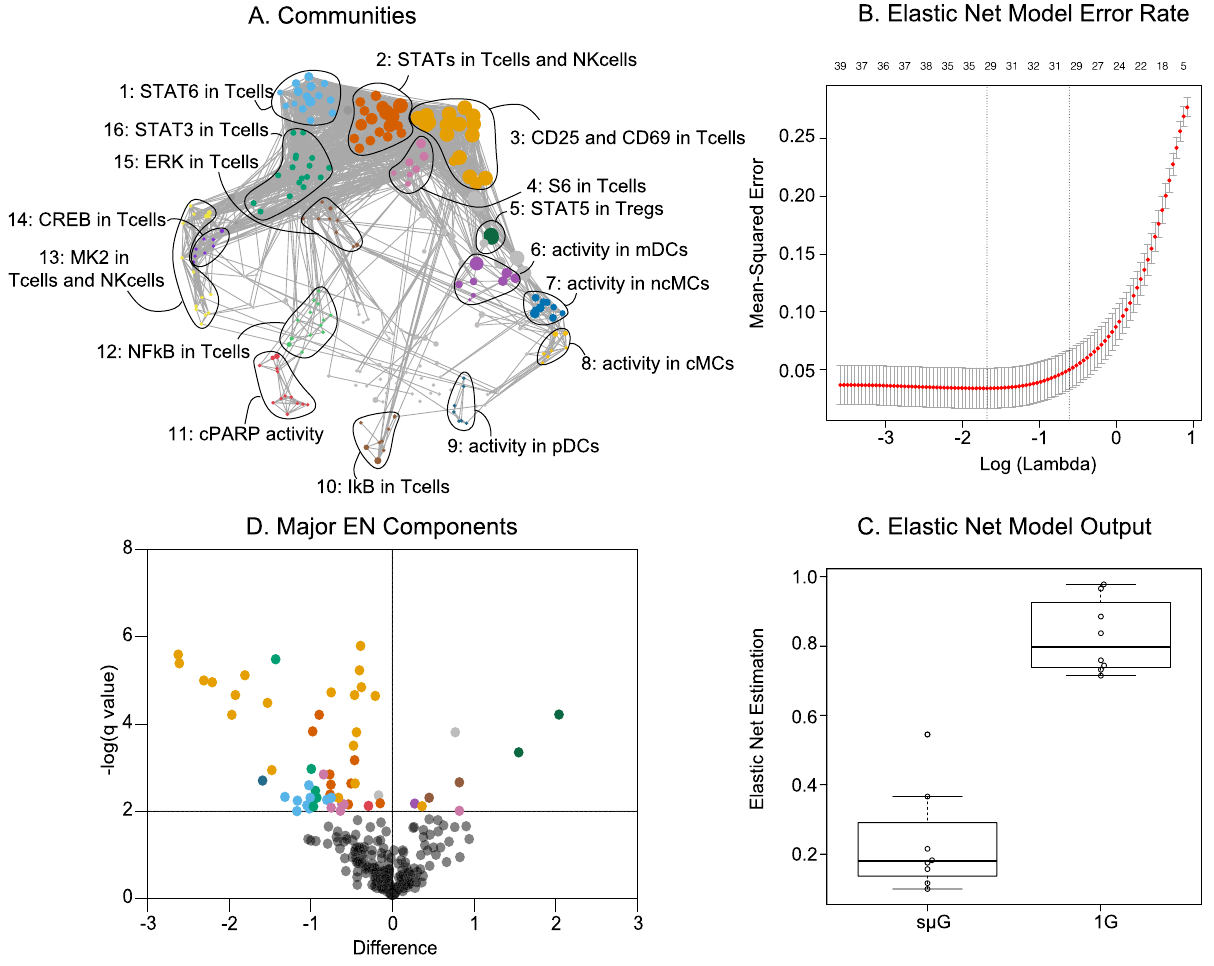
Figure 3. Multivariate modeling of immune cell adaptations to sµG analyzed using mass cytometry. ( A ) Correlation network depicting single-cell immune responses to ConA/anti-CD28 stimulation after sµG or 1G exposure. Nodes represent the protein expression or phosphorylation level of one of 14 functional proteomic markers for a given immune cell subset (asinh ratio relative to the unstimulated condition). Edges are proportional to the Spearman correlation between two nodes. The network segregates into 16 communities that were characterized based on the functional attribute that appeared most frequently in each community. ( B ) An EN method analysis of immune cell responses that differentiated samples exposed to sµG or 1G. The graph depicts model error rates after cross-validation across a range of regularization threshold [log(lambda)]. EN models with the lowest error rate (left vertical dotted line) and one standard deviation from the lowest error rate (right vertical line) are indicated. ( C ) EN model output ( p = 2E−4, Wilcox signed rank test, n = 8). ( D ) The dot plot illustrates -log (q value) comparing the sµG and 1G conditions (after 4 h ConA/anti-CD28 stimulation). Horizontal line at y = 2 signifies a significance level of 0.01. Significant features above the grey line are